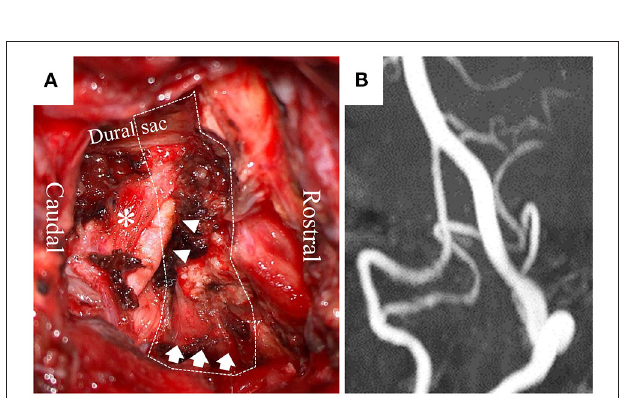
FIGURE 2 | Computed tomography angiography (CTA) with leftward head rotation shows the right PICA and VA as compressed (A) . The PICA was compressed in the narrow space surrounded by the posterior arch and lateral mass of the atlas and the superior articular facet of the axis ( B : sagittal image of the atlas; C : axial; D : coronal). The right VA was compressed by the anterior wall of the transverse foramen at the axis ( E : sagittal image of the axis). White arrowhead: PICA, black arrowhead: compressed PICA, arrow: compressed VA, *: occipital condyle, A: anterior, P: posterior.